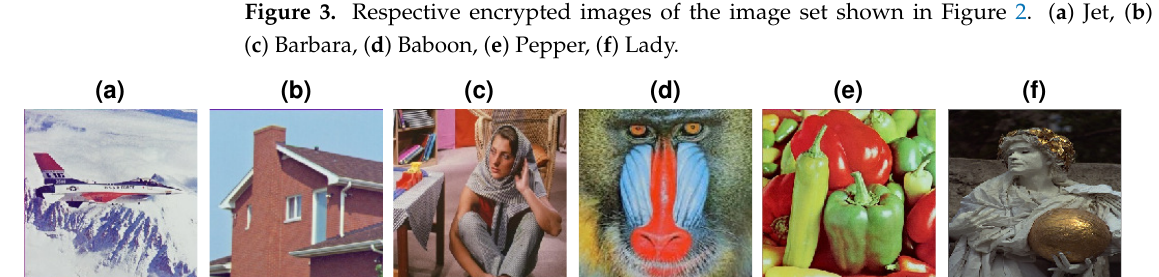
Figure 3. Respective encrypted images of the image set shown in Figure 2. ( a ) Jet, ( b ) Home,